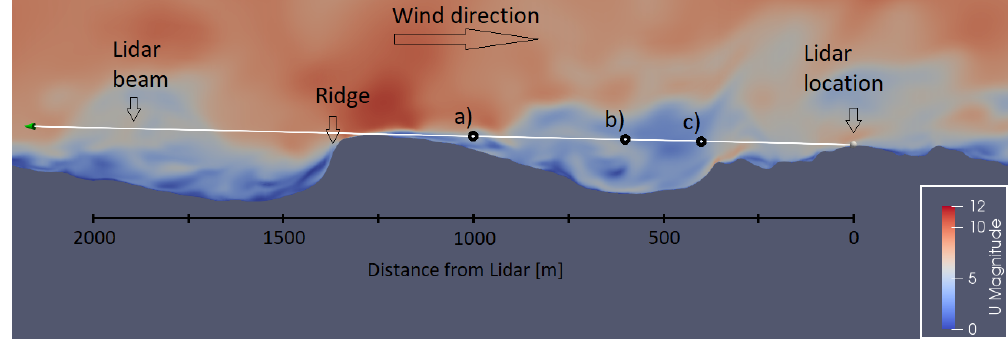
Figure 4. Schematic describing the location of the Lidar and meteorological mast, and the ridge of interest to the study. Flow model results were compared with Lidar measurements along the line-of-sight parallel to the mean flow, and points at distances ( a ) 1000m; ( b ) 600m; and ( c ) 400m from the Lidar were used for further